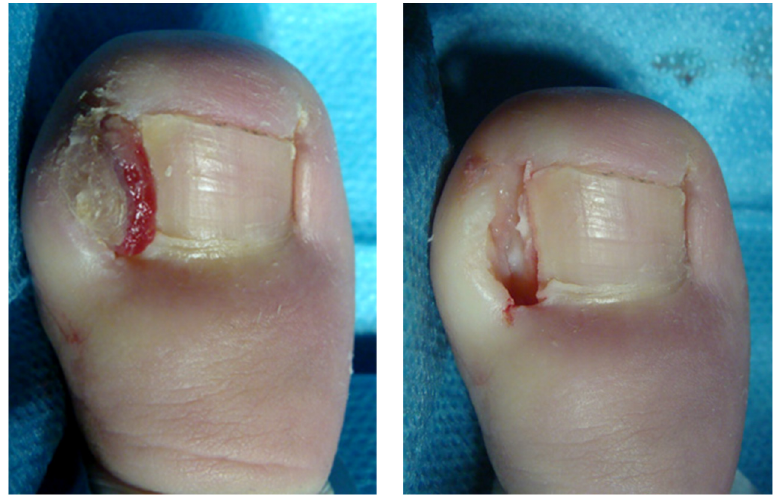
Figure 2. Stage III onychocryptosis in the lateral fold ( left image ). Aspect of the hallux after the Winograd procedure ( right image ).